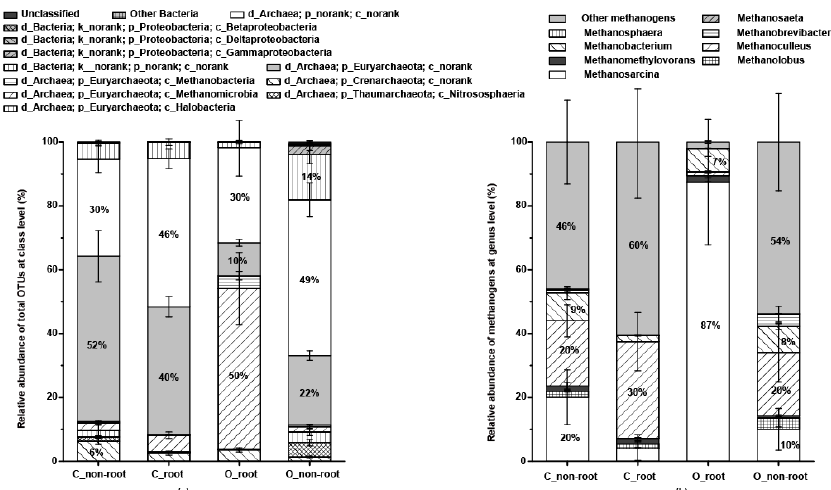
Figure 4. Relative abundance of the whole OTUs and methanogenic communities. ( a ) is the methanogenic communities classified at the taxonomic class level; ( b ) is the methanogenic communities classified at the taxonomic genus level. O_non-root, OTUs from the rice non-root soil of organic fertilizer treatment. C_non-root, OTUs from the rice non-root soil of no fertilizer treatment. O_ root, OTUs from the rice root soil of organic fertilizer treatment. C_ root, OTUs from the rice root soil of no fertilizer treatment. In the taxonomy database, due to the large data of microbial communities, there will be many taxonomic lineages in the intermediate level without a scientific name, labelled “no rank”. In addition, the taxonomic comparison is based on the selection of the confidence threshold. After BLAST, some hierarchical classification would receive relatively low scores, marked as “unclassified”.